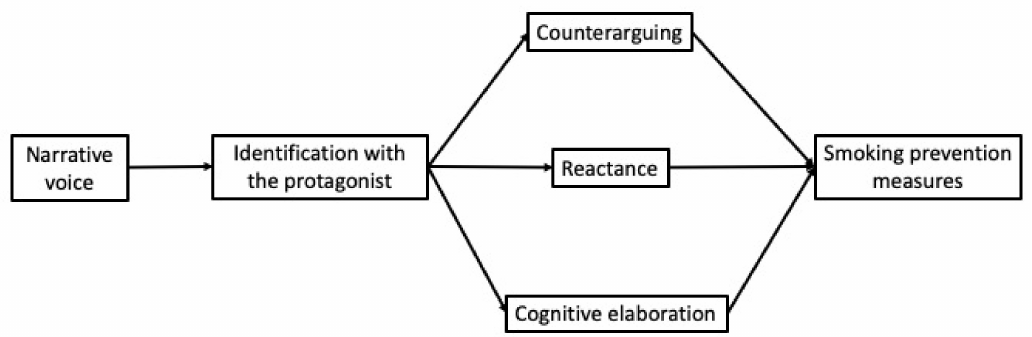
Figure 1. Hypothesized serial–parallel mediation model